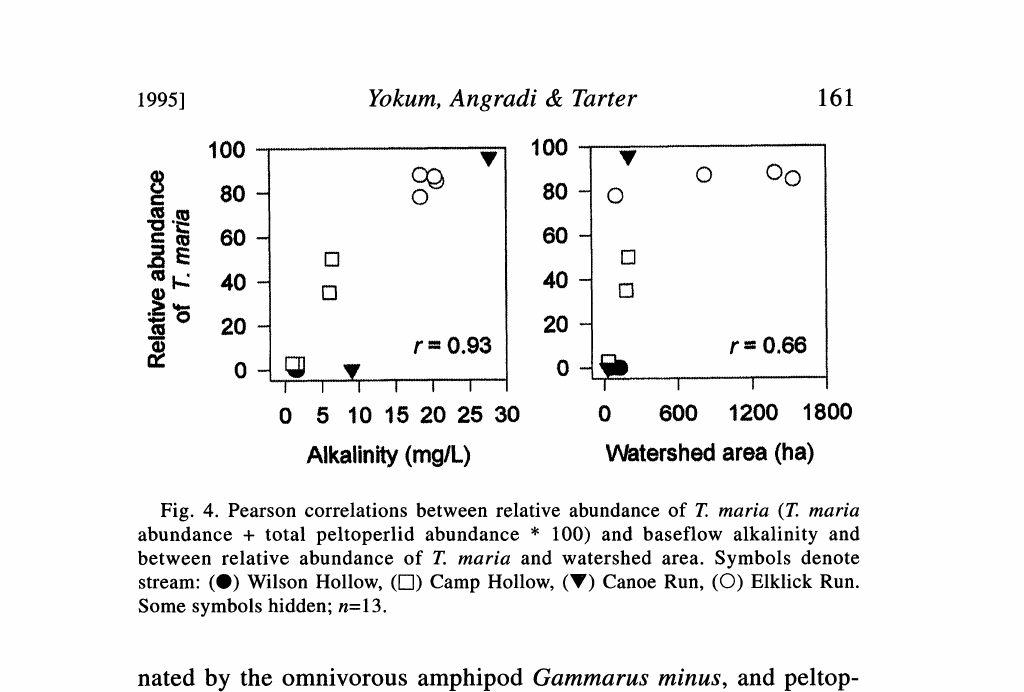
Fig. 4. Pearson correlations between relative abundance of T. maria (T. maria abundance + total peltoperlid abundance * 100) and baseflow alkalinity and between relative abundance of T. maria and watershed area. Symbols denote stream: (0) Wilson Hollow, (V-l) Camp Hollow, (’) Canoe Run, ((C)) Elklick Run. Some symbols hidden; n=l